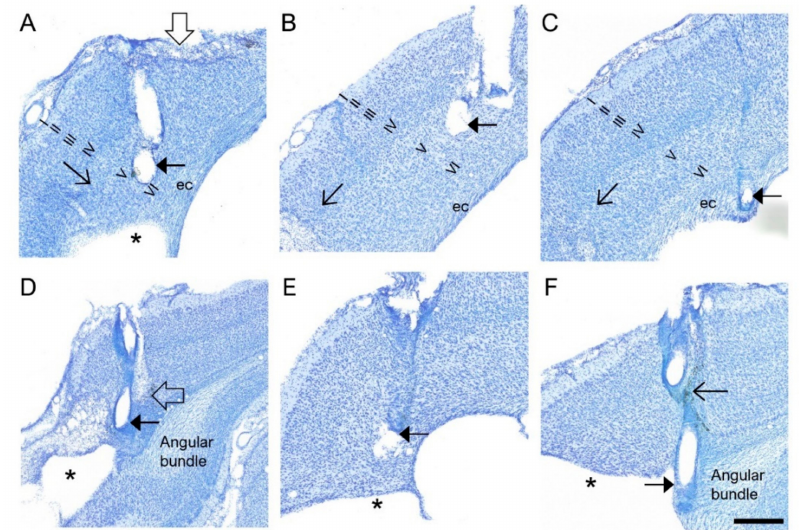
Figure 3. ( A – F ) Electrode tracts. Histological images from the coronal thionine-stained sections of 6 rats, showing the tracts of the bipolar intracortical electrodes and location of the lower electrode tip (filled arrowhead). Roman numerals indicate the cortical layers. In panels ( A , B ) the electrode tip is located in layer V of the perilesional cortex. Note the electrode track-related lesion on the surface of the brain in panel ( A ) (open filled arrow). In panel ( A ), the electrode tip is within 500 µ m from the edge of the TBI-induced lesion cavity (asterisk). In panel ( C ), the electrode tip is in the external capsule (ec). In panel ( D ) the electrode tip is within the cortical lesion, close to the angular bundle. Open arrow points to the electrode path associated neurodegeneration. In panel ( E ), the electrode tip is close to the edge of the lesion cavity (asterisk). In panel ( F ), the electrode tip is within the angular bundle (closed arrowhead). The open arrowhead points to the location of the upper electrode in layer IV (open arrow). The dark staining indicates iron deposits (arrowheads) adjacent to the electrode path. Scale bar = 500 µ